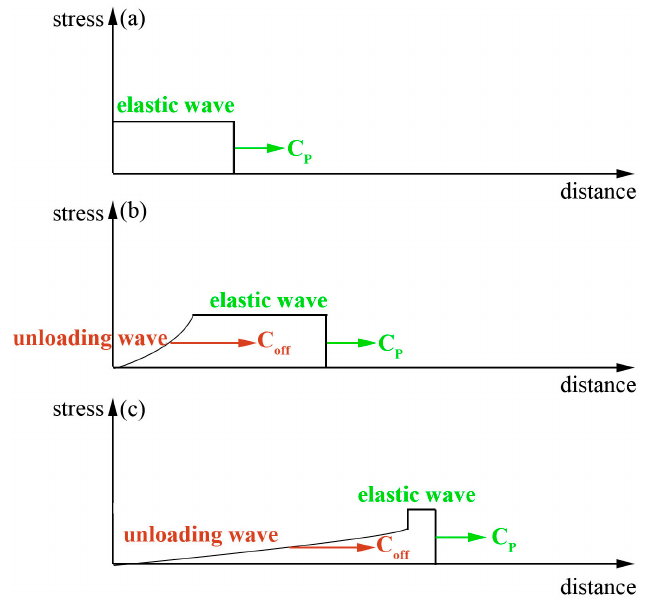
Figure 9. Schematic propagation of elastic waves: C p is the velocity of the elastic wave; C off is the velocity of the unloading wave. ( a ) Only elastic wave; ( b ) unloading wave occurs; ( c ) the elastic wave is almost be caught up by unloading wave.